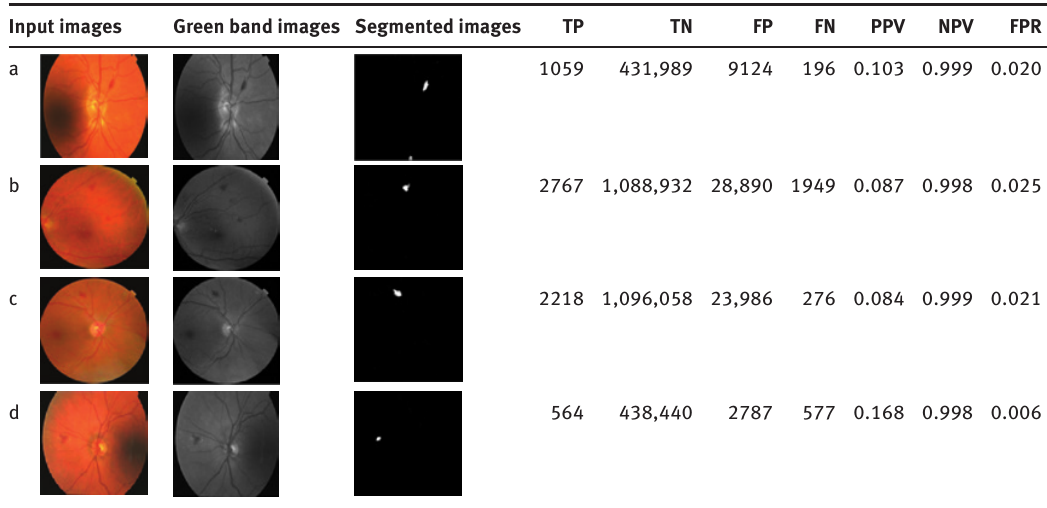
Table 2: Proposed Values of Retinal Hemorrhage